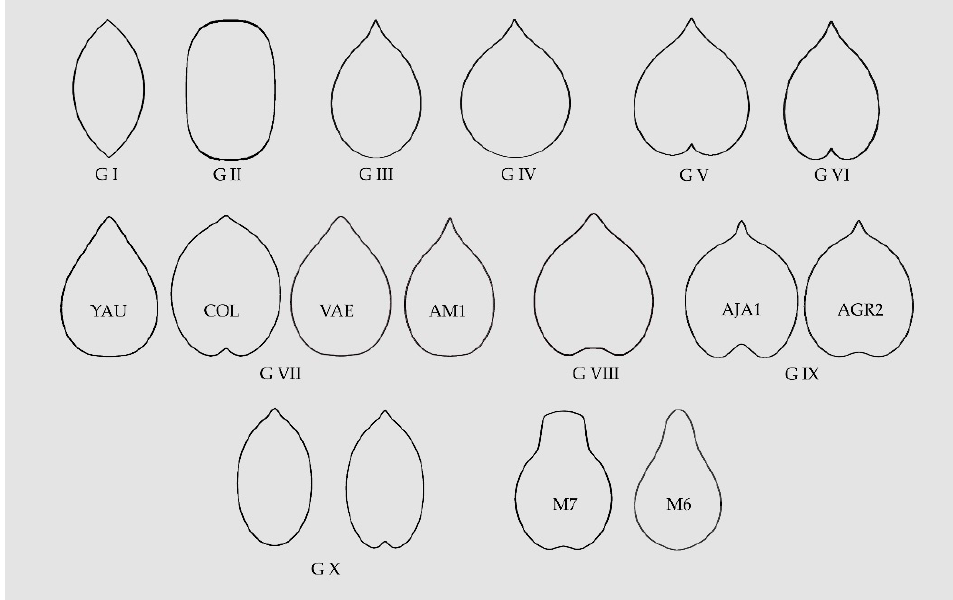
Figure 10. A summary of the models found for the description and quantification of seed shape in the Vitaceae. G I, G II and G III are lenses, superellipses and elongated water drops, respectively; G IV, G V and G VI correspond to water drops, heart curves and elongated heart curves, respectively; G VII contains four models corresponding to other elongated curves; G VIII presents an example of the heart curves of the Cayratia and Pseudocayratia types; G IX, heart curves of the Squared Heart Curves (SqHCs) type in Ampelocissus and broadened models of Ampelocissus and Ampelopsis, and G X, Elongated Superellipse-Heart Curves (ESHCs), frequent in Tetrastigma species and observed also in Cissus species and R. rhomboidea. Labelled as M7 and M6 are two models used in the description of seeds of grape varieties and as precursors for other models [45,65].